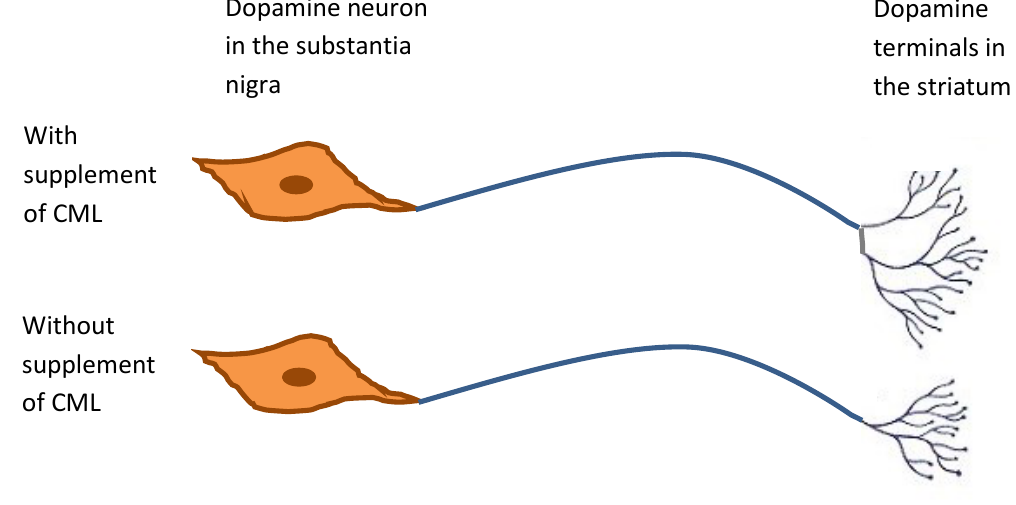
Figure 2. Potential mechanism for the effect of dietary ganglioside-containing complex milk lipid on learning and memory in postnatal rats. The diagram shows the nigra-striatal pathway in which the dopamine neurons project from the nigra to the striatum. Supplementation may increase the synaptic connectivity in the striatal dopamine terminals, depicted as amplification in the number of synaptic processes emerging from the terminal, and hence increase efficiency of dopamine